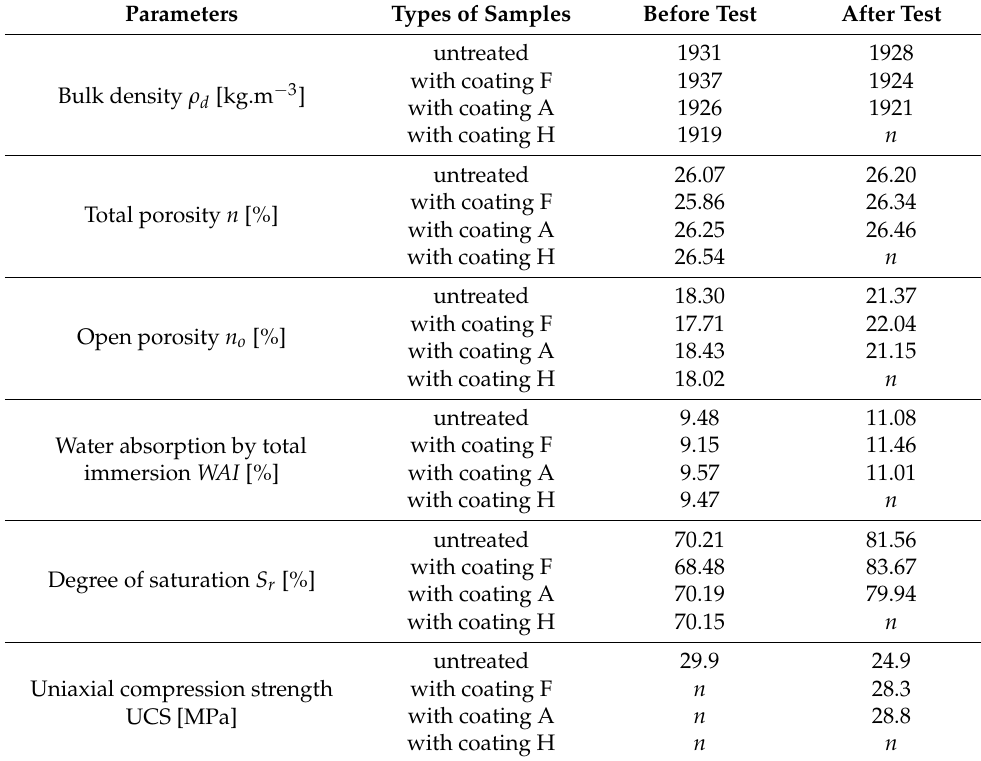
Table 3. Impact of the freeze–thaw cycling on the properties of untreated samples and samples with selected coatings—HS ( n = not tested).